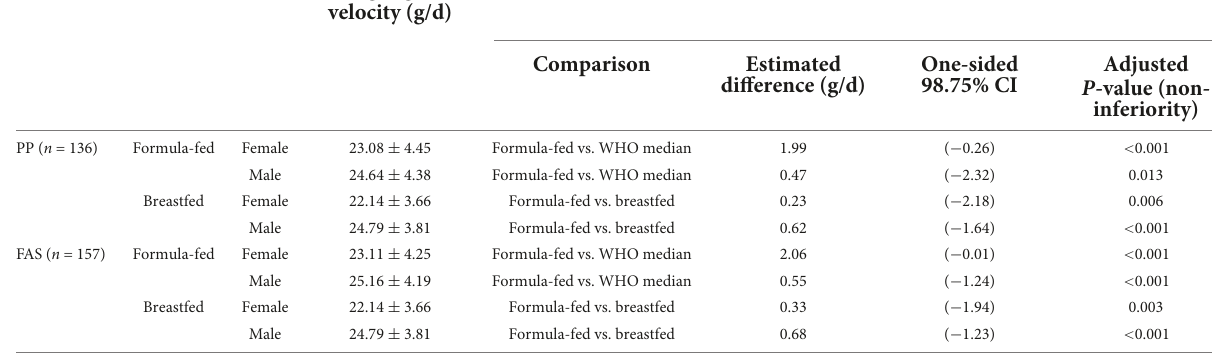
TABLE 2 Weight gain velocity (g/d) from 0 to 6 months (i.e., enrollment to 180 days). Analysis set